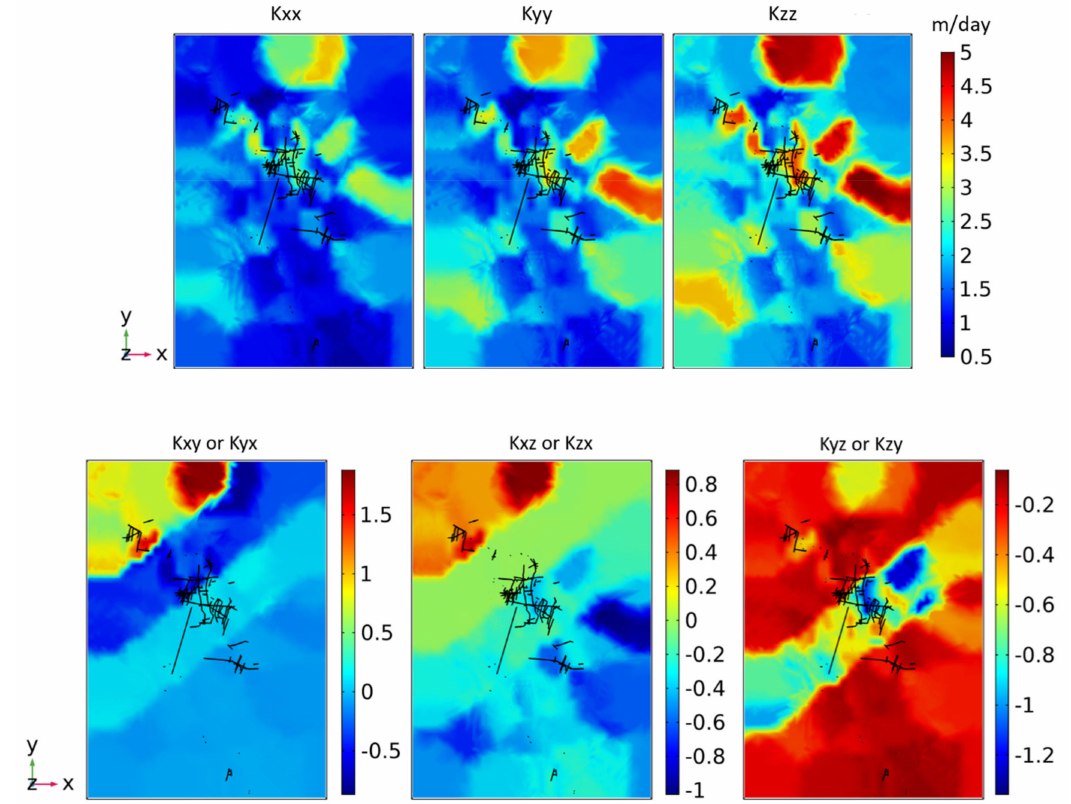
Figure 22. Horizontal cross-sections of the hydraulic conductivity model (in m/day) estimated for the Kapunda area (after Wang et al.